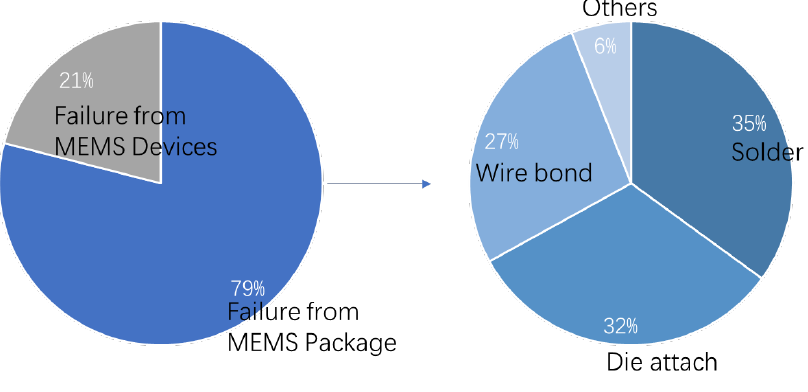
Figure 14. Percentage of failure sites for all 20,000 g tests [136]